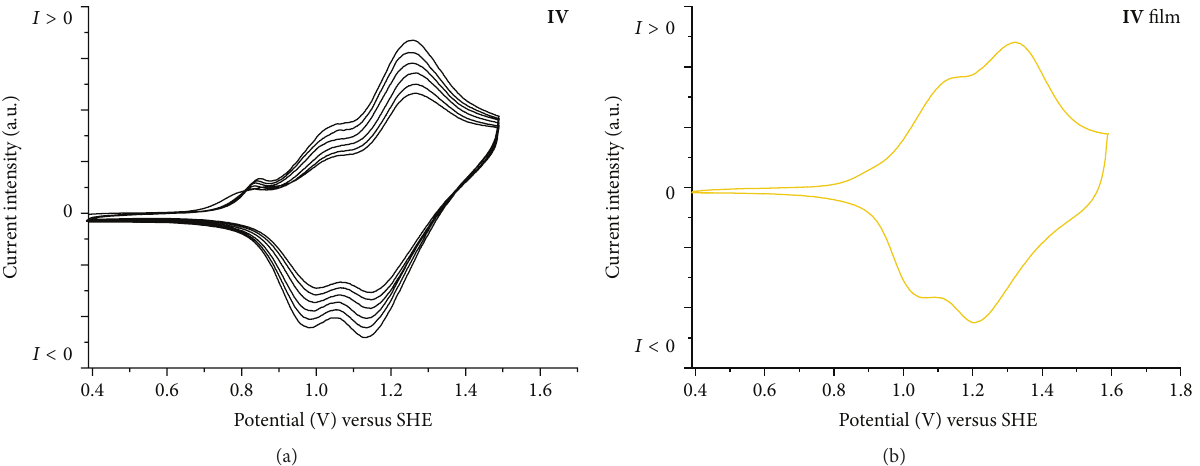
Figure 4: (a) Cyclic voltammograms of IV obtained from six consecutive oxidation scans and (b) cyclic voltammogram in fresh dichloromethane electrolytic solution of the resulting modified Pt electrode obtained after 20